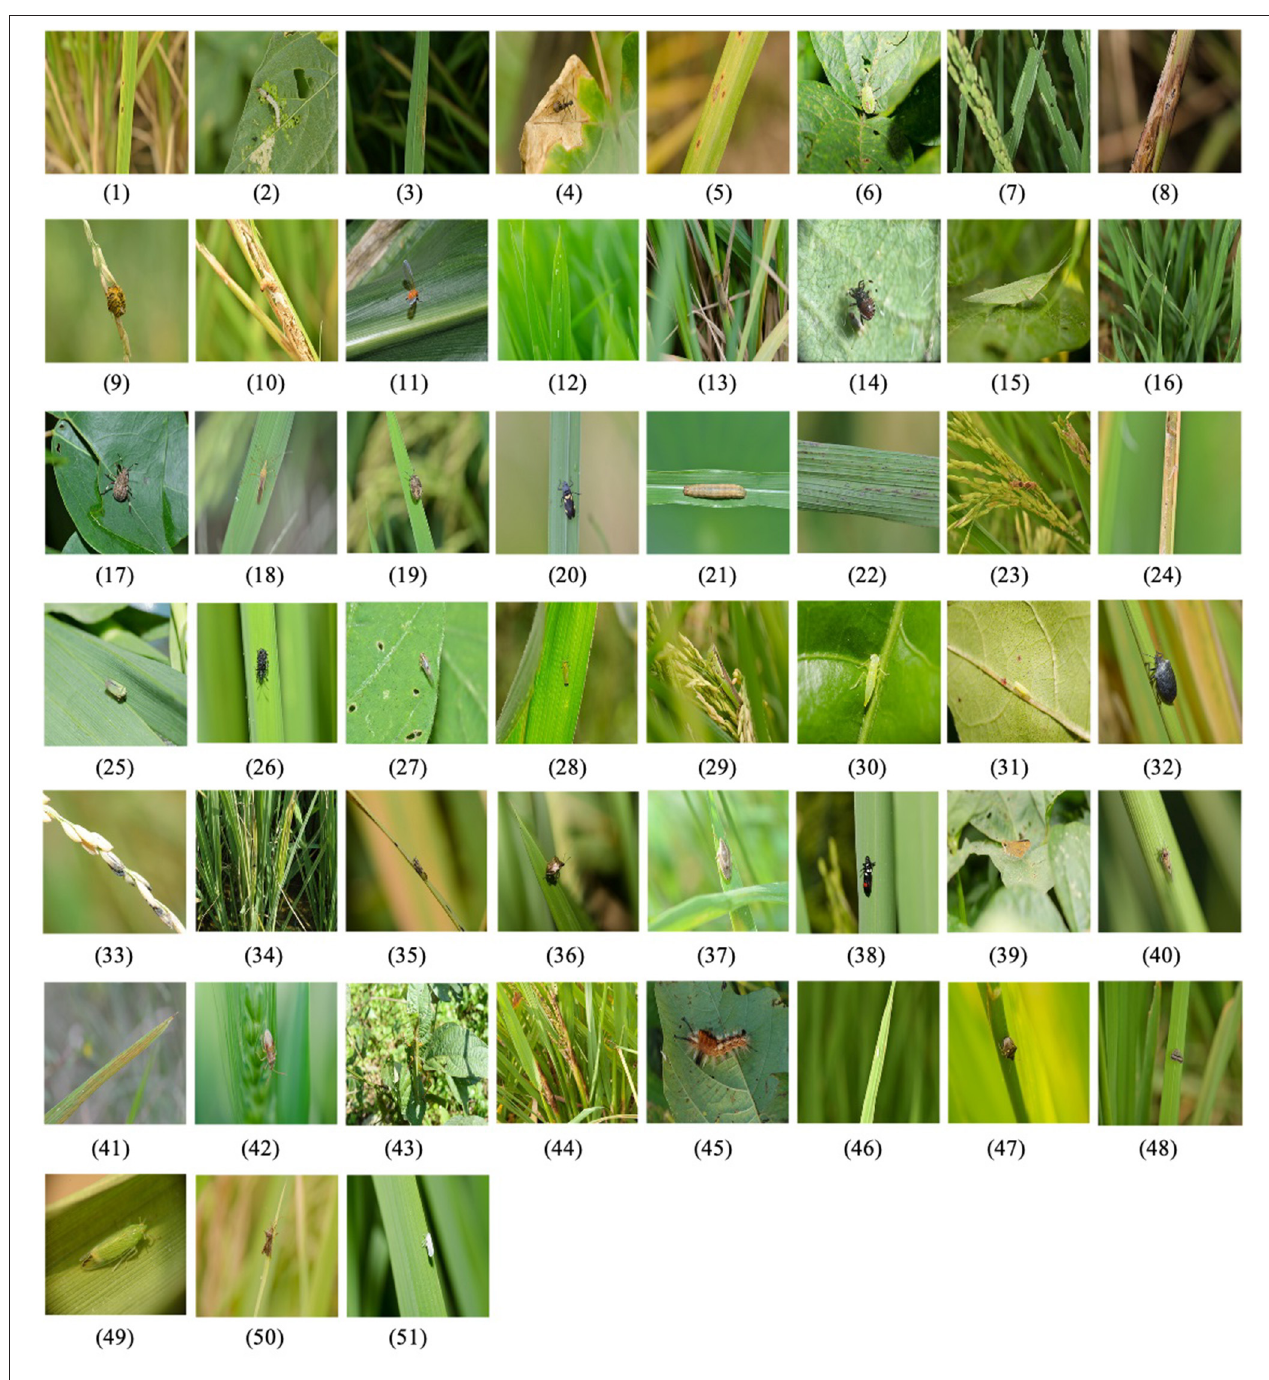
FIGURE 3 | Examples of rice pests and diseases in RPDID. The number under each image corresponds to the category in Table 1 , indicating the category to which the image belongs.